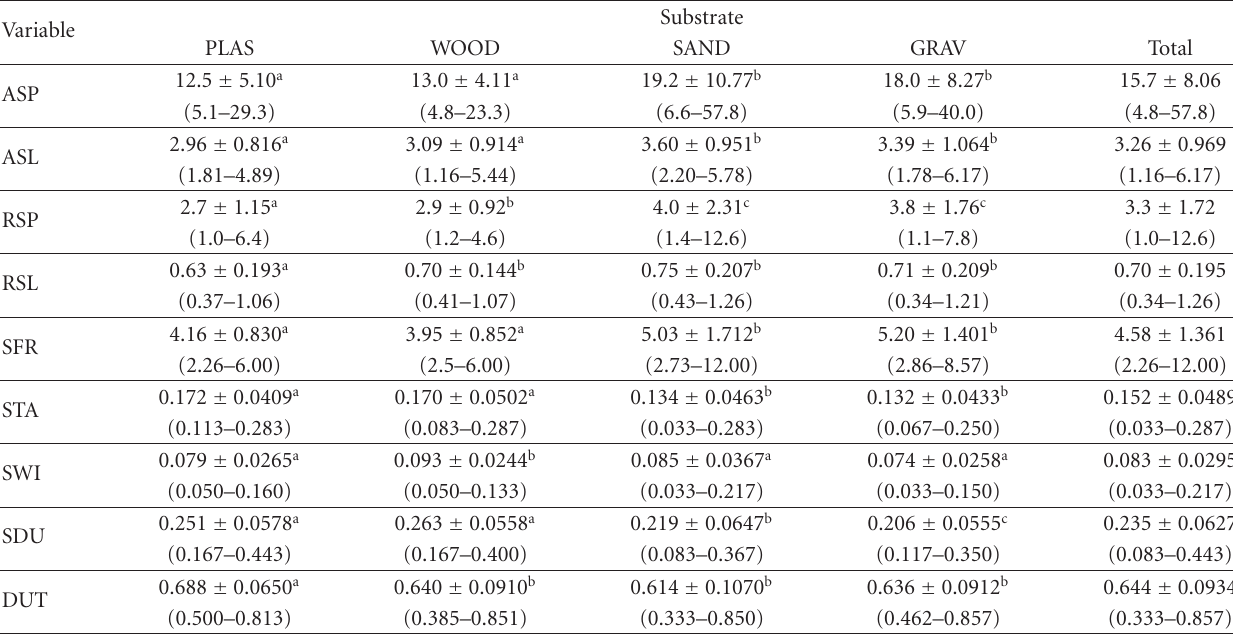
Table 1: Kinematic variables recorded for Colobodactylus taunayi on di ff erent substrates. Mean ± SD, range in parenthesis, and n = 72 for each cell. Relative measures result from raw values divided by individual snout-vent length (SVL). Friedman tests indicated significant di ff erences ( P < 0 . 001) among substrates for all variables. After Bonferroni correction, significant Wilcoxon pairwise contrasts among substrates for each variable were shown as di ff erent letters (a, b, and